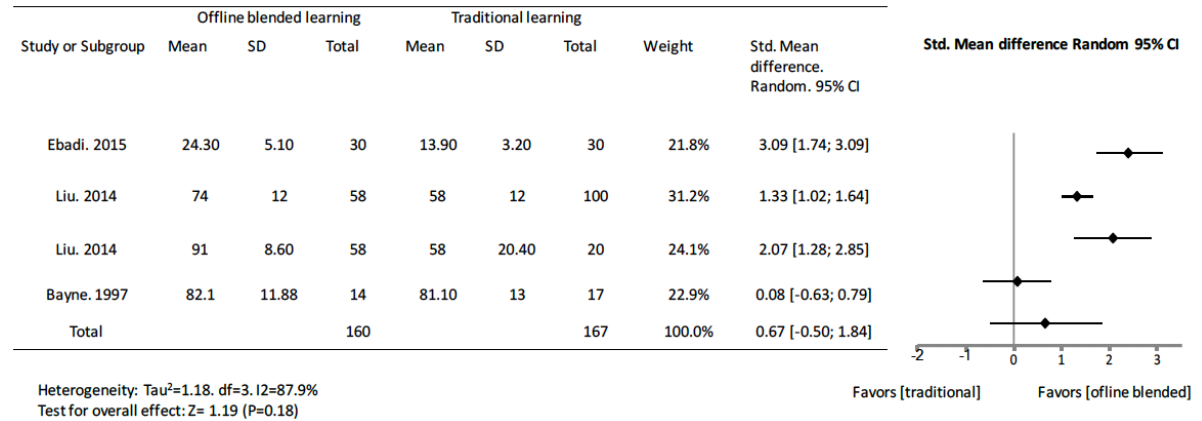
Figure 4. Forest plot of offline blended learning to traditional learning comparison for knowledge outcomes. df: degree of freedom; CI: confidence